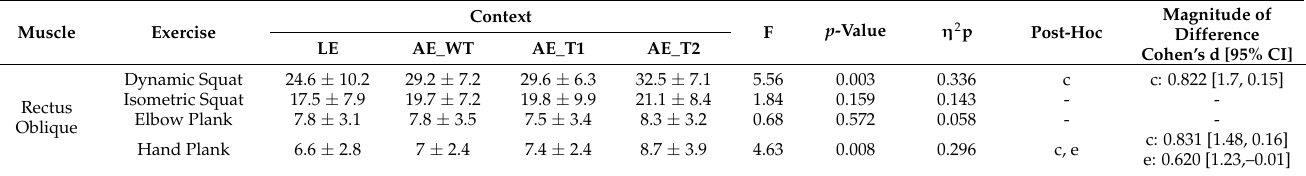
Table 6. Descriptive analysis (mean ± standard deviation) of EMG magnitude (%) and inferential analysis of the activation of the rectus oblique muscle as a function of the exercises and taking into account the context